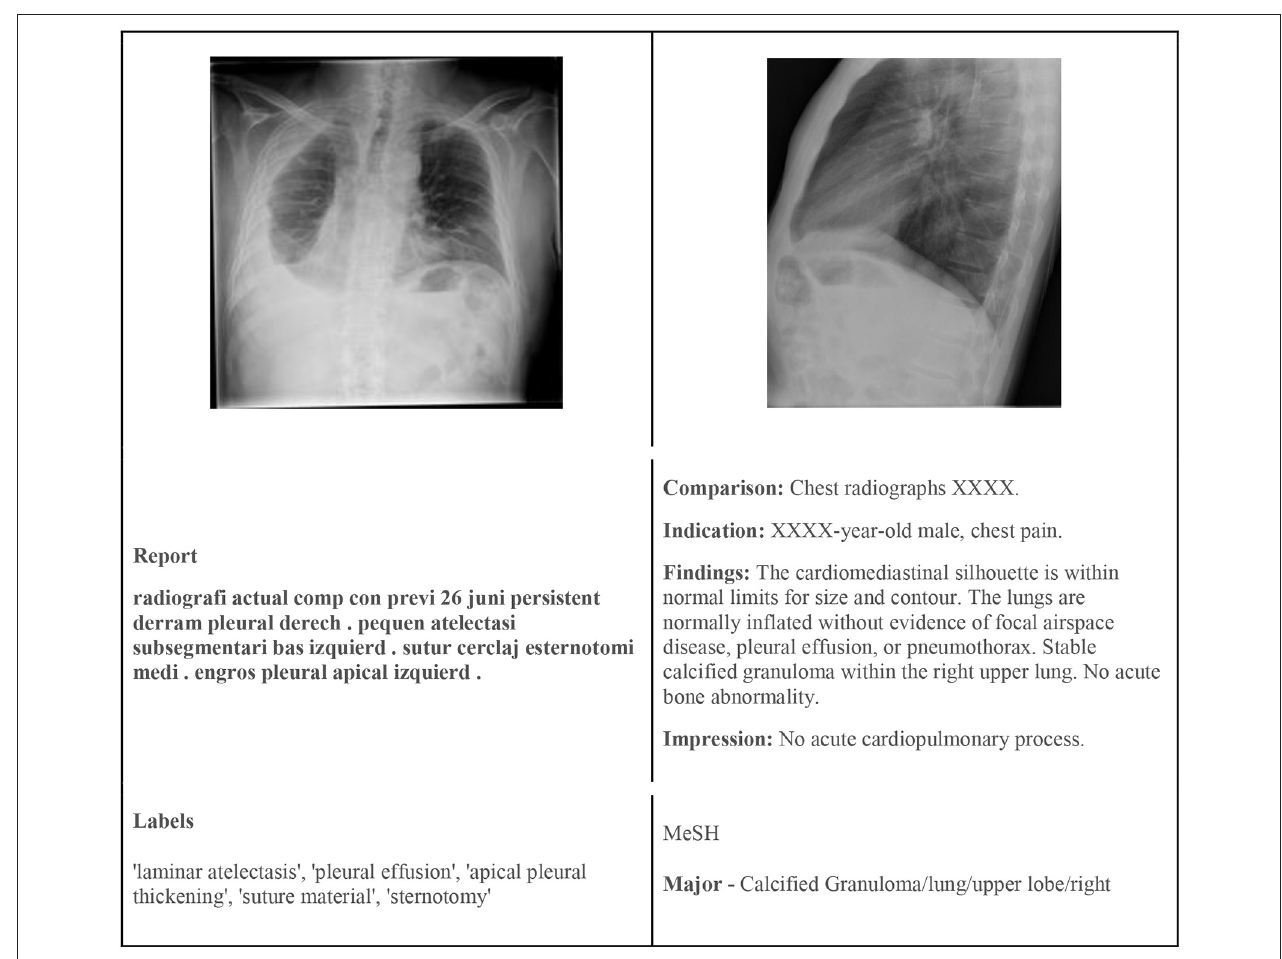
FIGURE 1 | (Left) Sample image from PadChest with findings. (Right) Sample image from the Indiana Chest X-Ray dataset with MeSH annotation.